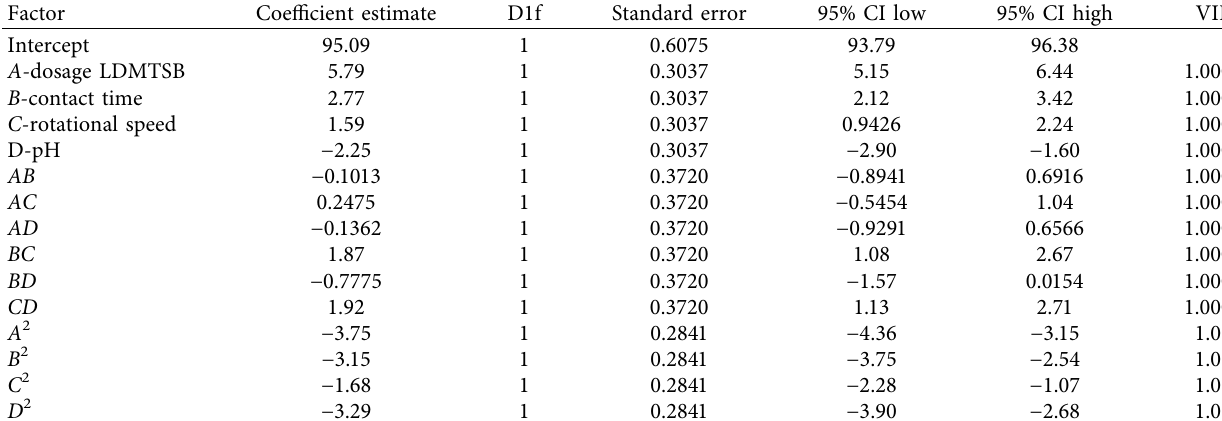
Table 6: Coefficients of the coded variable.